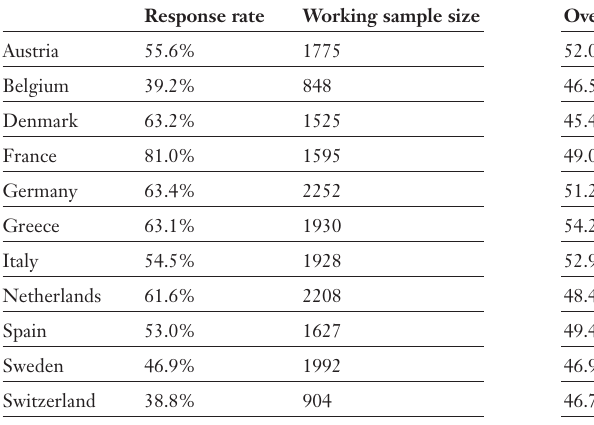
Overweight (BMI 25.0–29.9 kg/m 2 ) and obesity (BMI 0 30.0 kg/m 2 ) popula- tions’ estimated prevalence, by gen- der and country, in non-institutionalised individuals aged 0 50 years (weighted